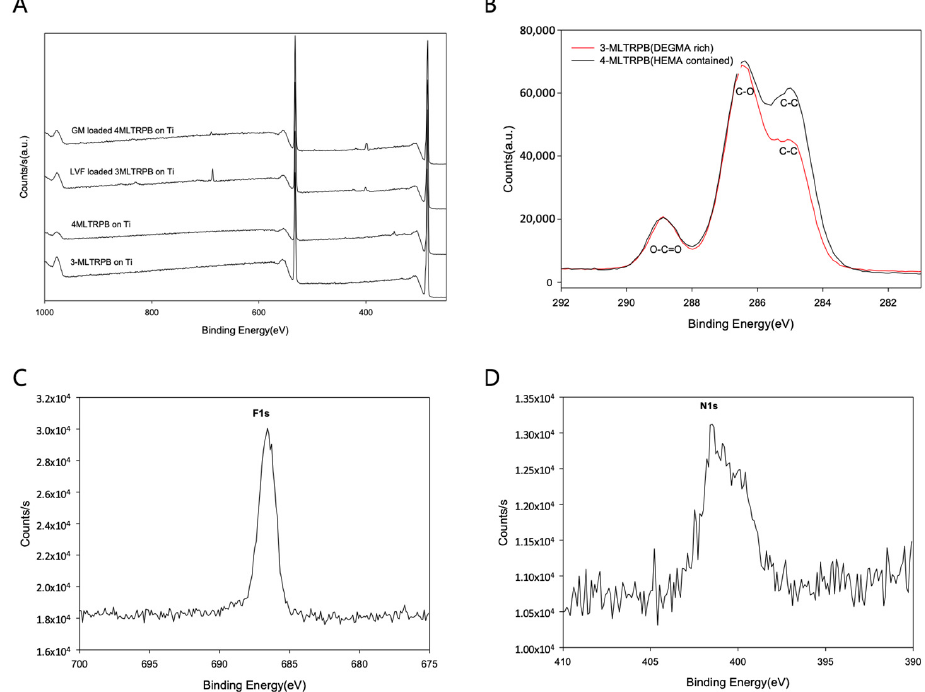
Figure 2. XPS survey spectra of ( A ) 1-MLTRPB on titanium implant: multi XPS data, ( B ) 2- MLTRPB on titanium implant: 1-MLTRPB(DEGMA rich) and 2-MLTRPB(HEMA contained), ( C ) LVF loaded 3-MLTRPB: LVF loaded 3-MLTRPB(DEGMA rich), and ( D ) GM loaded 4-MLTRPB (GM loaded 4-MLTRPB(HEMA contained)) .